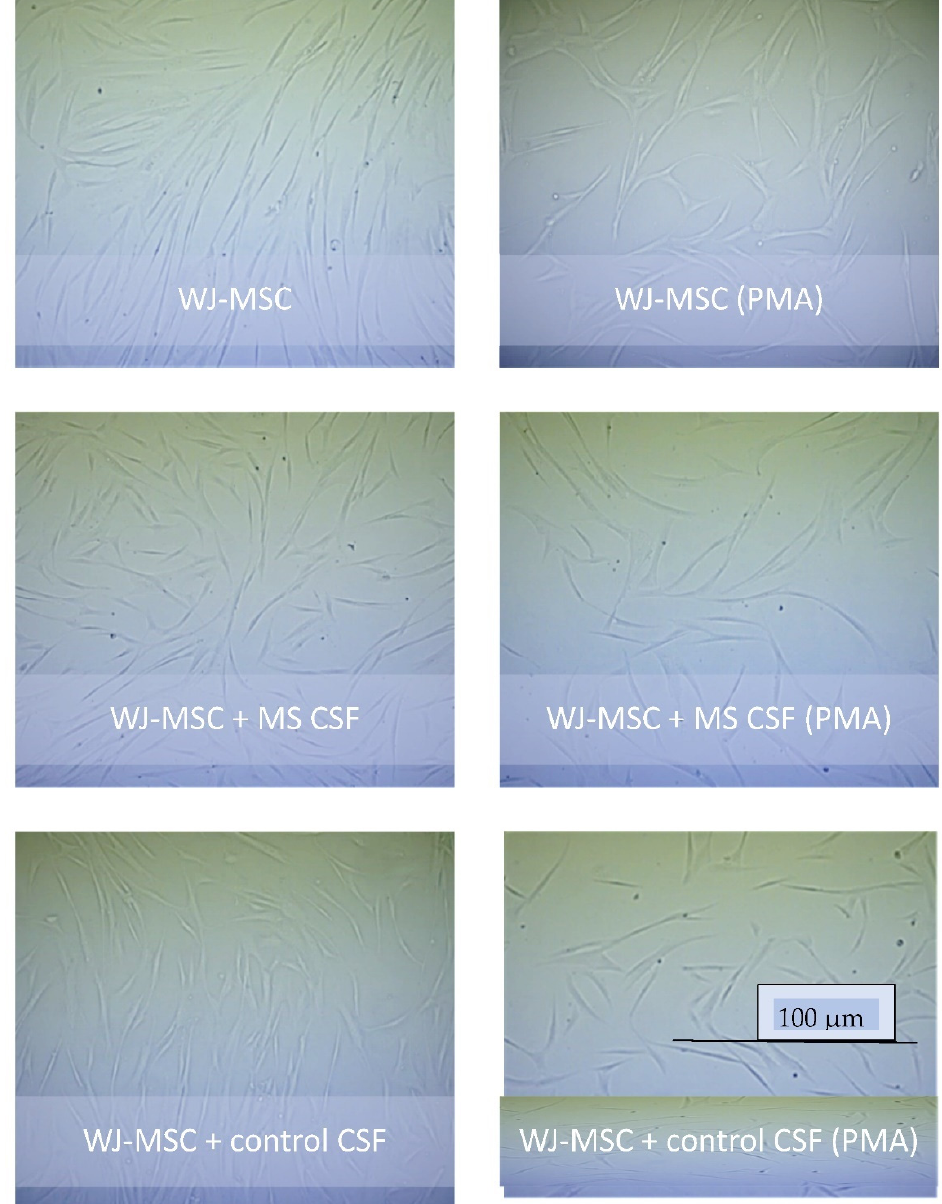
Figure 1. Microscopic features of cell survival and growth of WJ-MSCs in medium and PMA conditions and with MS CSF versus control CSF addition. Scale bar: 100 μ m.